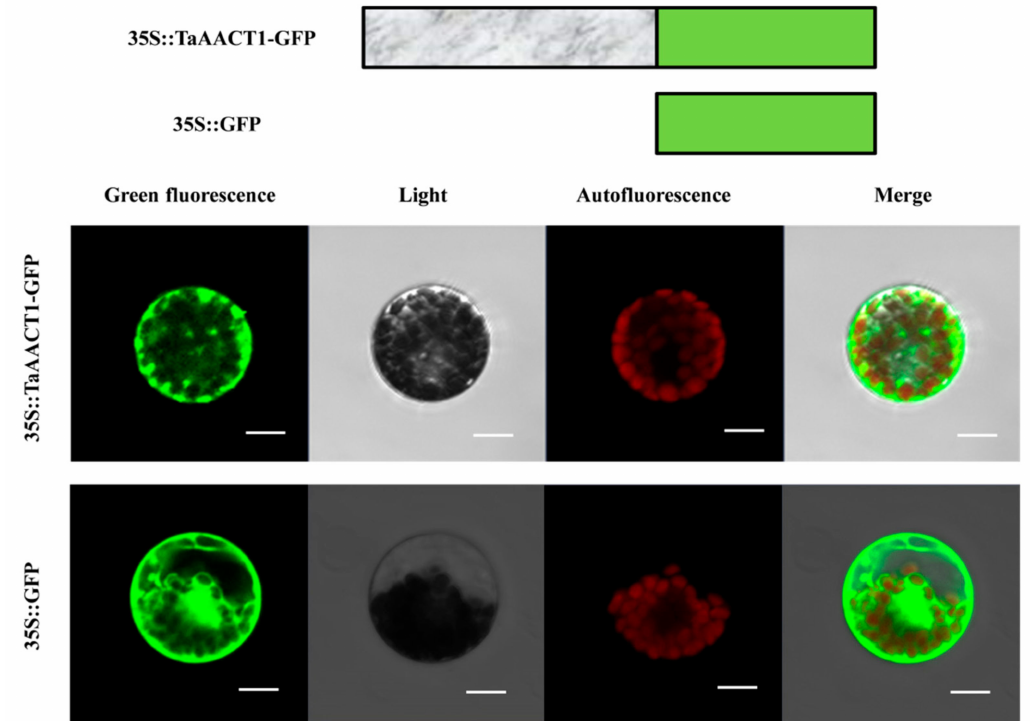
Figure 8. Subcellular localization of TaAACT1 in wheat mesophyll protoplasts. The fused TaAACT1- GFP protein and control GFP protein are transiently expressed in wheat mesophyll protoplasts. Scale bars = 20 µ m. Green color represents the green fluorescence. Red color represents